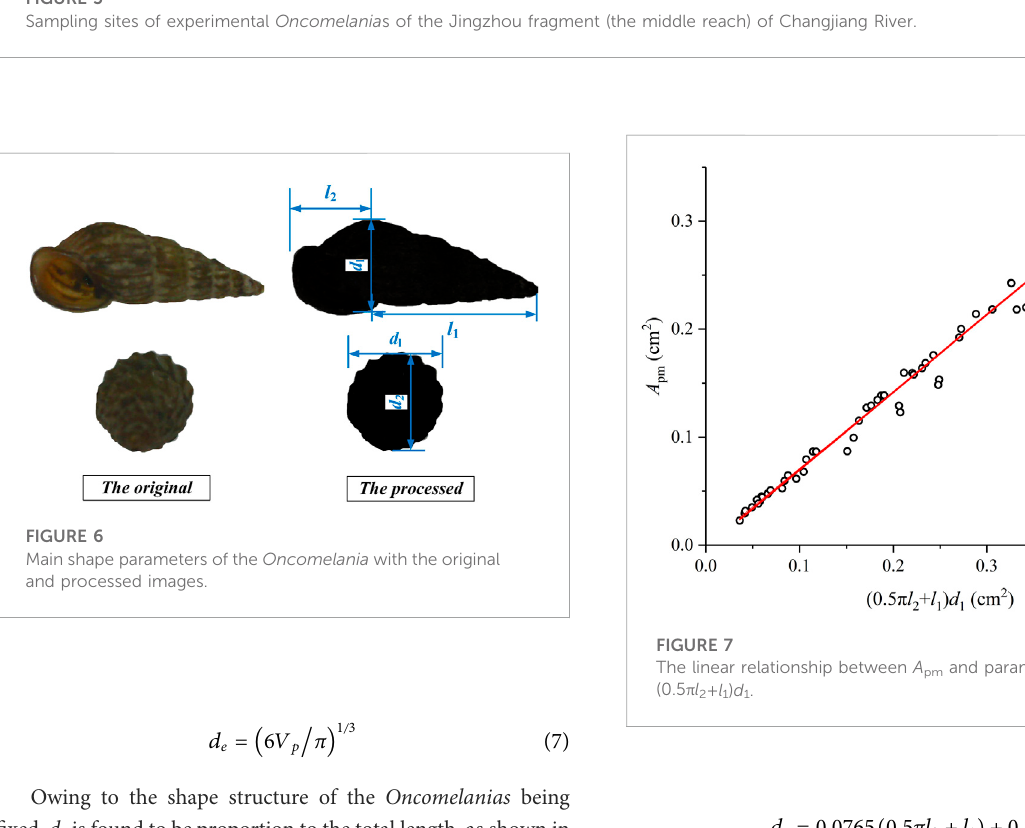
with the correlation coef fi cient R 2 = 0.988.